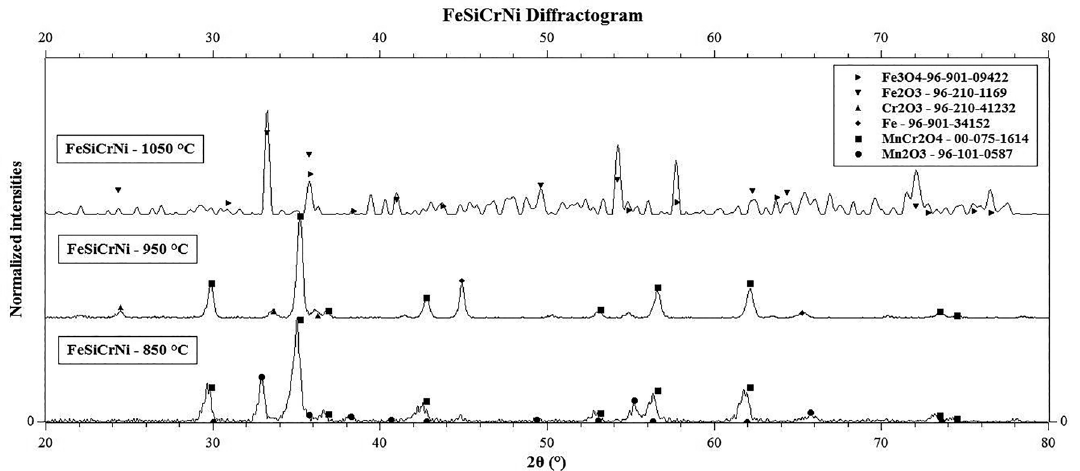
Figure 5. XRD oxidized layer diffractogram after 850, 950 and 1050 ºC tests